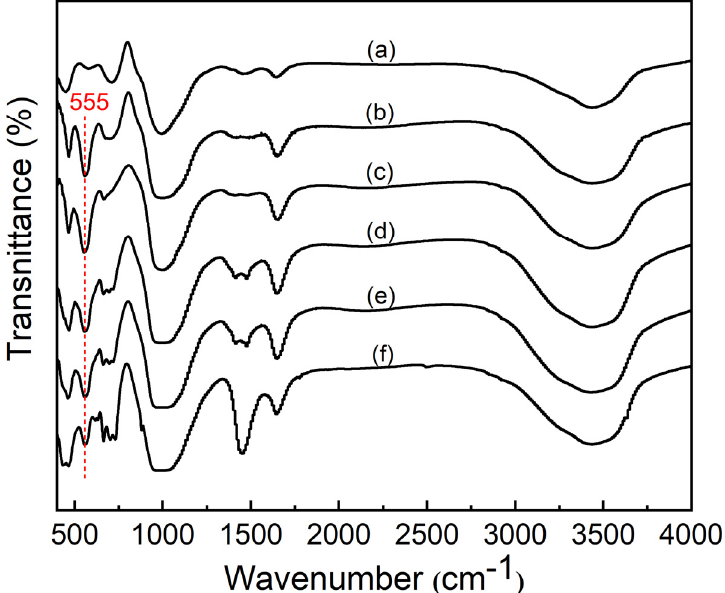
Figure 4. FTIR spectra of samples synthesized at different NaOH concentrations (NaOH concentra- tions: ( a ) 0.25 mol·L − 1 , ( b ) 0.5 mol·L − 1 , ( c ) 1.0 mol·L − 1 , ( d ) 1.5 mol·L − 1 , ( e ) 2.0 mol·L − 1 and ( f ) 2.5 mol·L − 1 ).